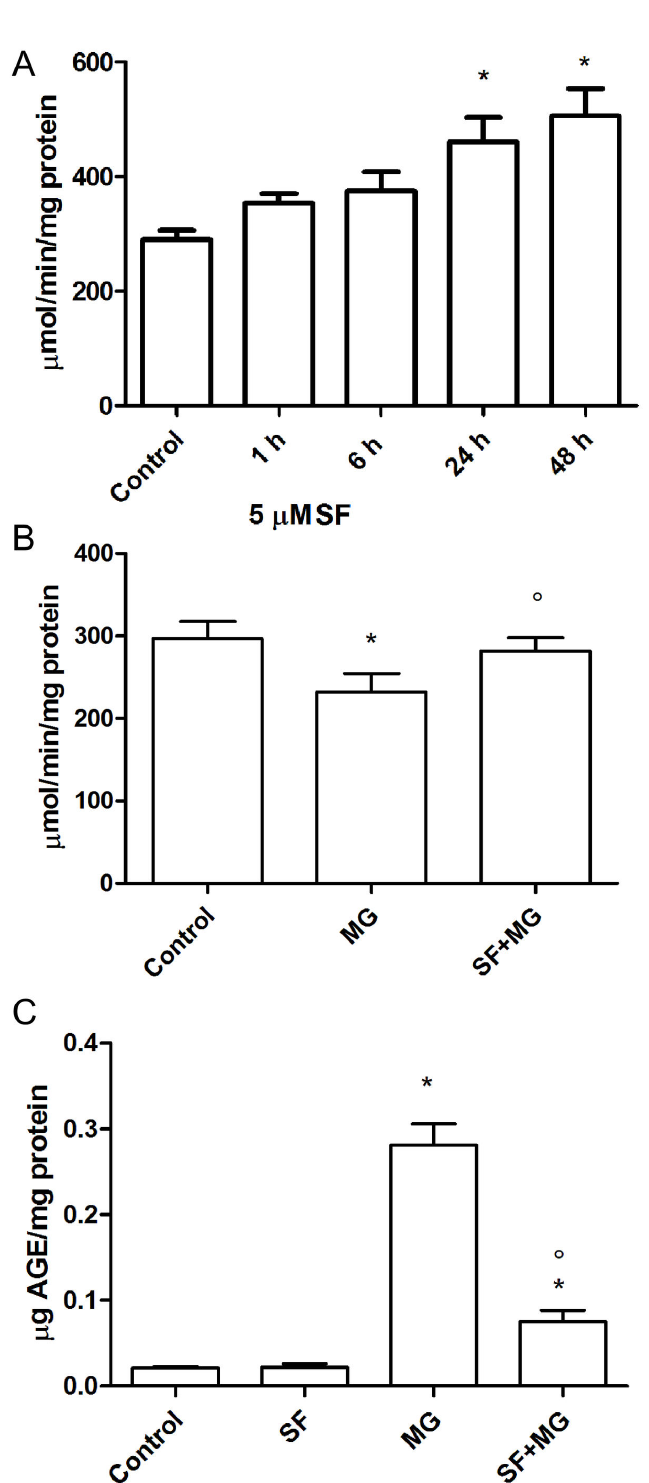
Figure 9. Effect of SF against MG-induced glycation. ( A ) Cardiomyocytes were treated with 5 µM SF for different time intervals (1-48 h) and GLO1 enzyme activity was measured by a spectrophotometric method. ( B ) Cardiomyocytes were treated with 5 µM SF for 24 h before addition of 1 mM MG, and GLO1 enzyme activity was measured by a spectrophotometric method. ( C ) Cardiomyocytes were treated with 5 µM SF for 24 h before addition of 1 mM MG, and AGE formation was evaluated by AGE-ELISA using a specific anti-AGE antibody. Data are presented as mean ± SD, n = 4 in each group, * p<0.05 vs Control; ° p<0.05 vs MG. doi: 10.1371/journal.pone.0083283.g009 PLOS ONE |